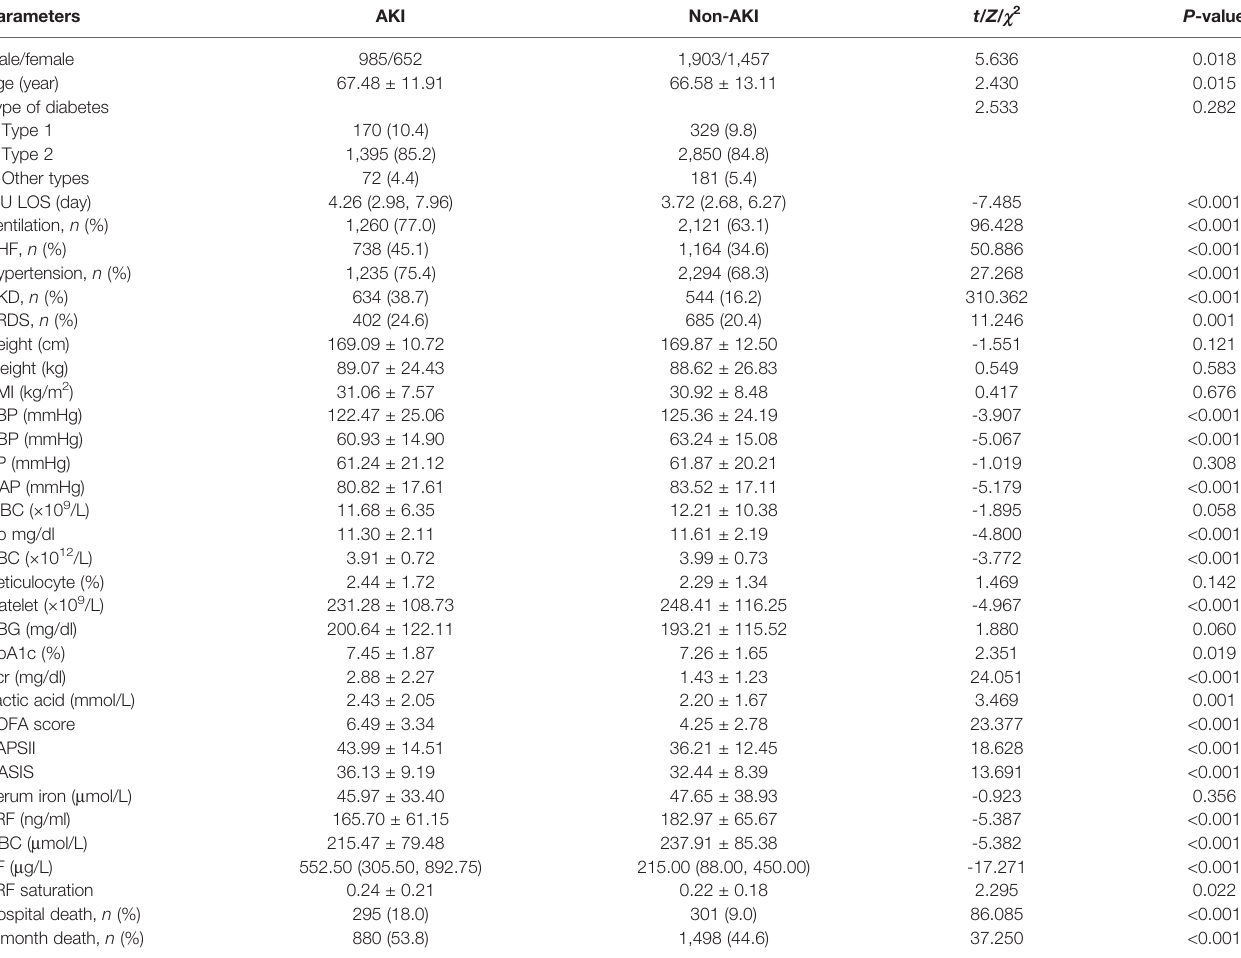
TABLE 1 | Baseline characteristics between acute kidney injury (AKI) and non-AKI groups. Parameters